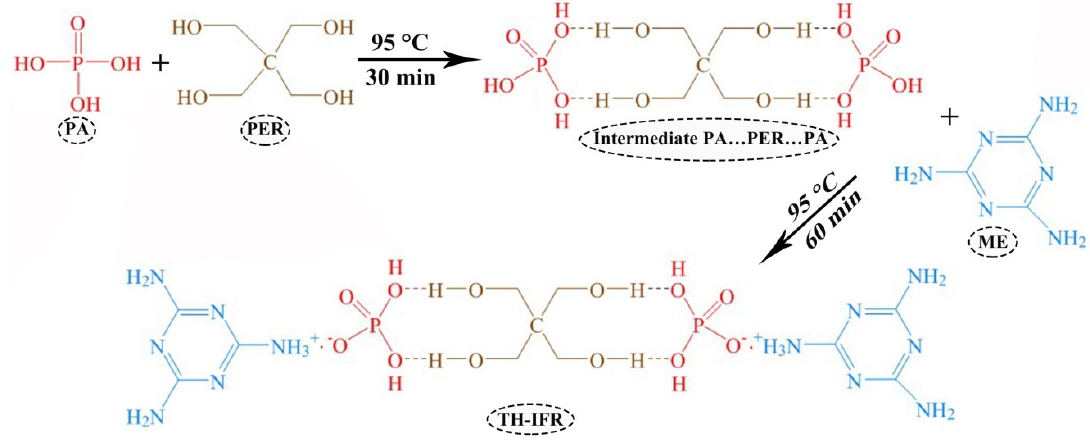
Figure 1. The schematic diagram for synthesizing TH-IFR.